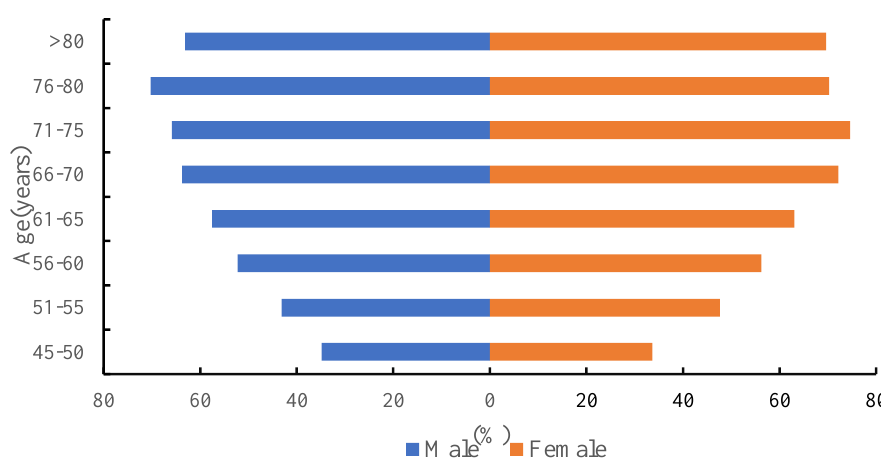
Figure 1. Weighted prevalence of multimorbidity by age and gender.